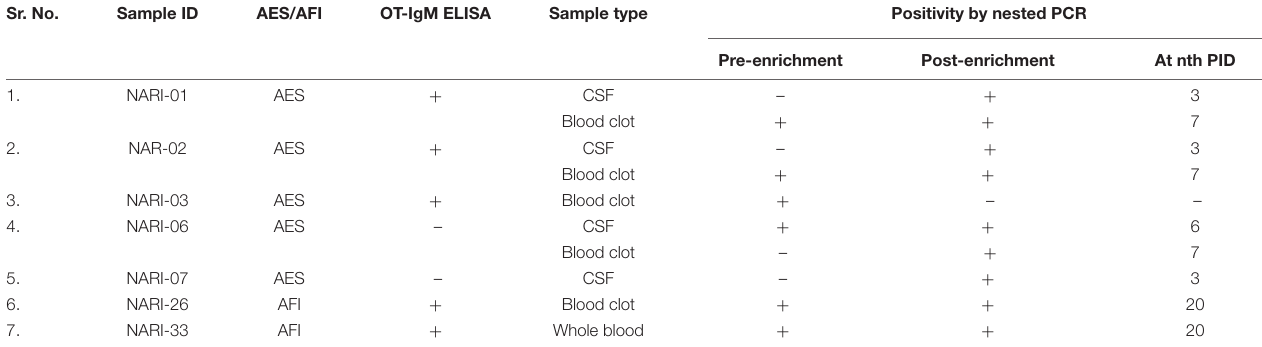
TABLE 2 | Molecular detection of samples positive for OT (pre- and post-enrichment) along with the serological results. Sr.